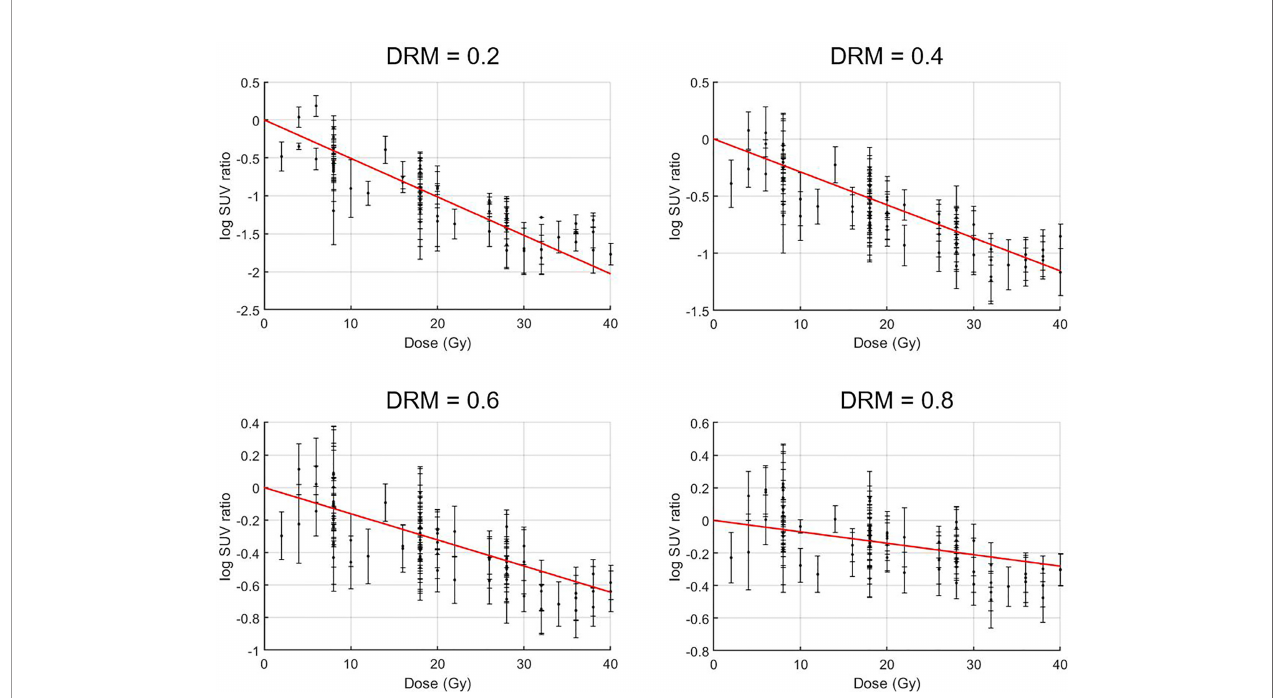
FIGURE 4 | Treatment dose versus logarithm standard uptake value (SUV) change ratio for tumor voxels with their average dose – response DRM being 0.2, 0.4, 0.6, and 0.8. Tumor voxel SUV change ratio = SUV( d )/SUV 0 , i.e., tumor voxel SUV measured at a given dose level d normalized to its baseline SUV 0